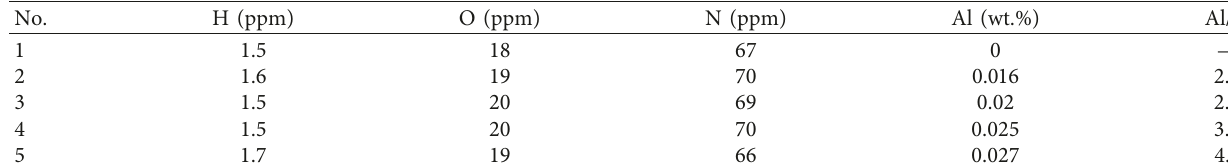
Table 2: The contents of H, O, and N in 34CrNiMo6 steel.